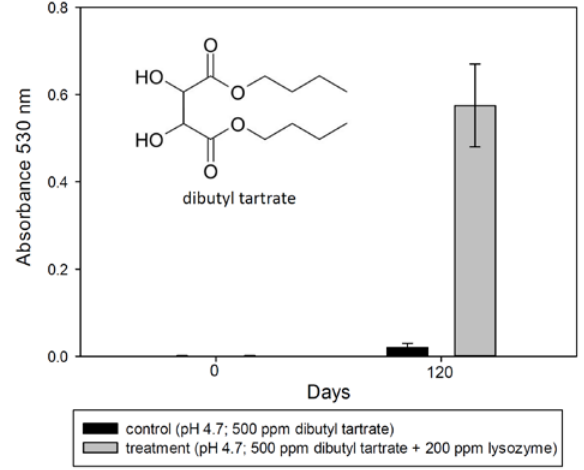
Figure 4. Free tartaric acid released from the model ester dibutyl tartrate after 120 days of storage in a model system in the presence of lysozyme without microbial activity.